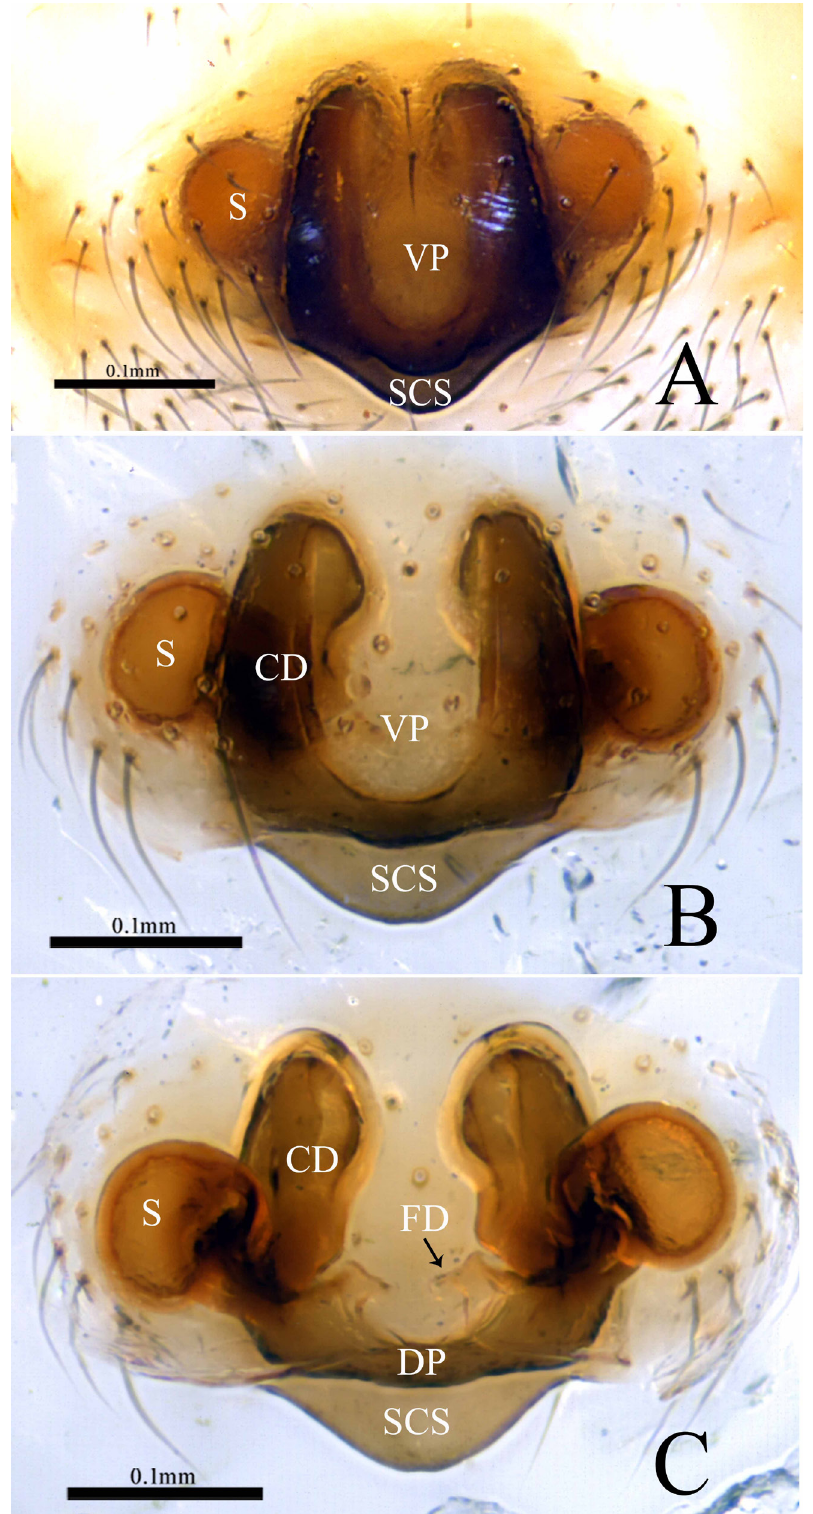
Fig. 8. Yuelushannus barbatus sp. nov., female, allotype (YLS-17-0301~02). A . Epigyne, ventral view (before being dissected from the body). B . Epigyne, ventral view (after being dissected from the body). C . Vulva, dorsal view. Scale bars: 0.1